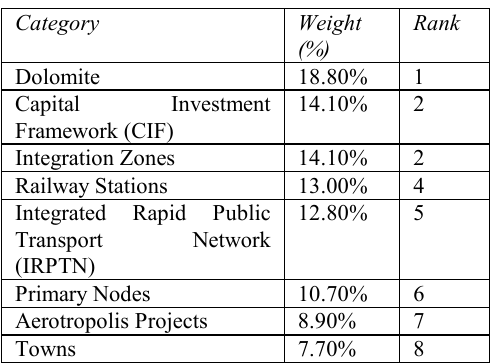
Table 2: Criteria and weighting to identify very well-located areas for urban development for expropriation purposes